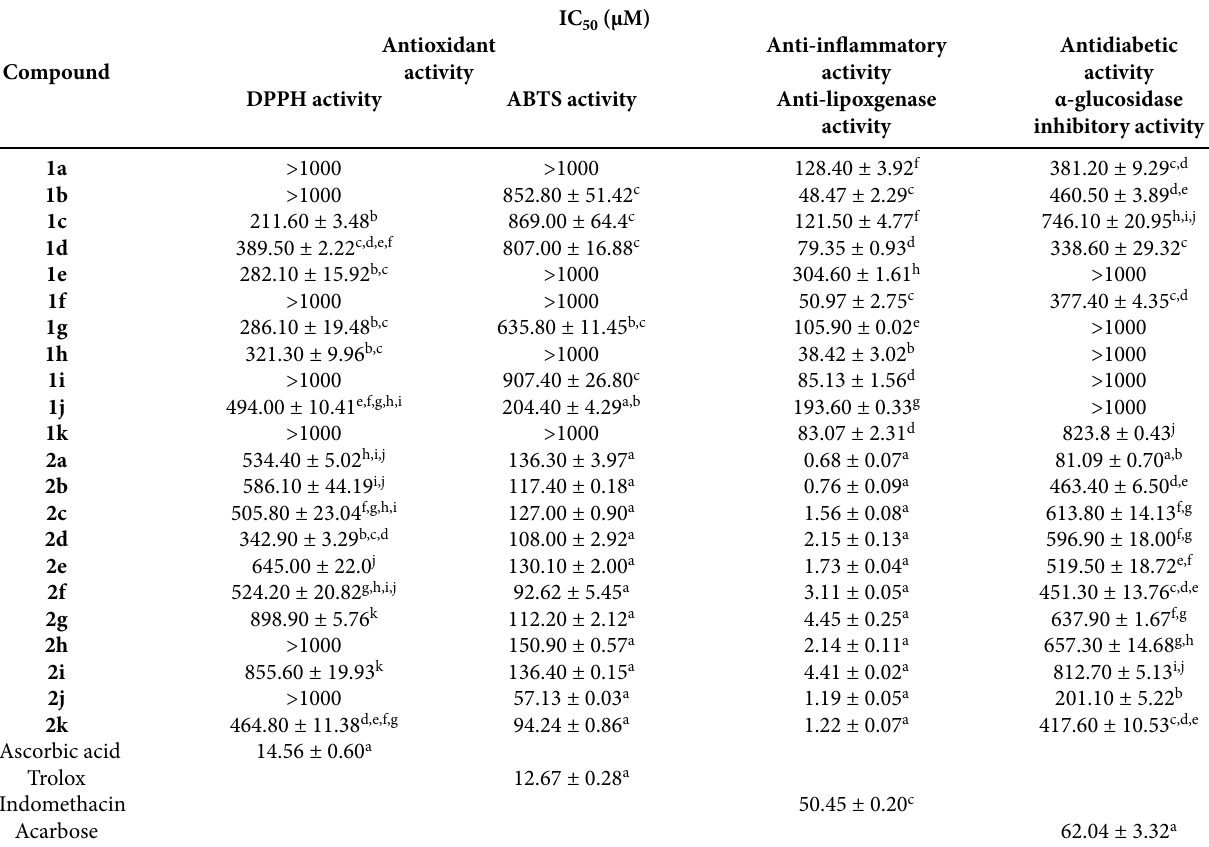
* Each value in the table is represented as mean ± SD ( n = 4). Different letter superscripts in the same column indicate significant differences ( p < 0.05).